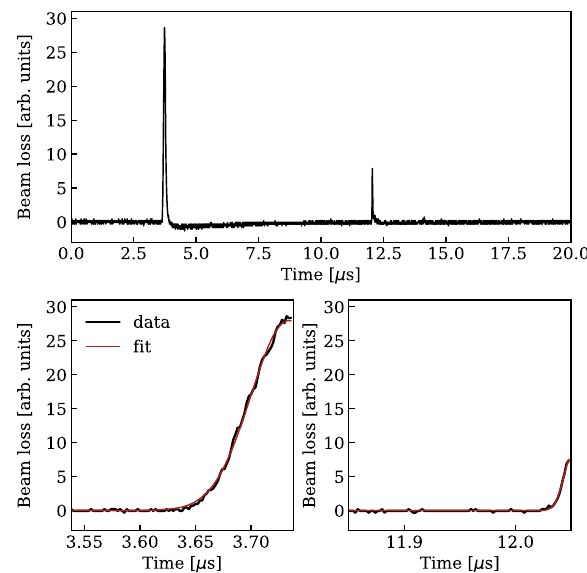
FIG. 12. Example of a fast BLM signal recorded in SS15 (top). The losses generated by the island sweeping through the blade of the dummy septum cause the first spike, while the second one represents the losses of the core. The bottom plots present detailed views of the island and core losses (left and right plot, respectively) together with the fitted Gaussian model.